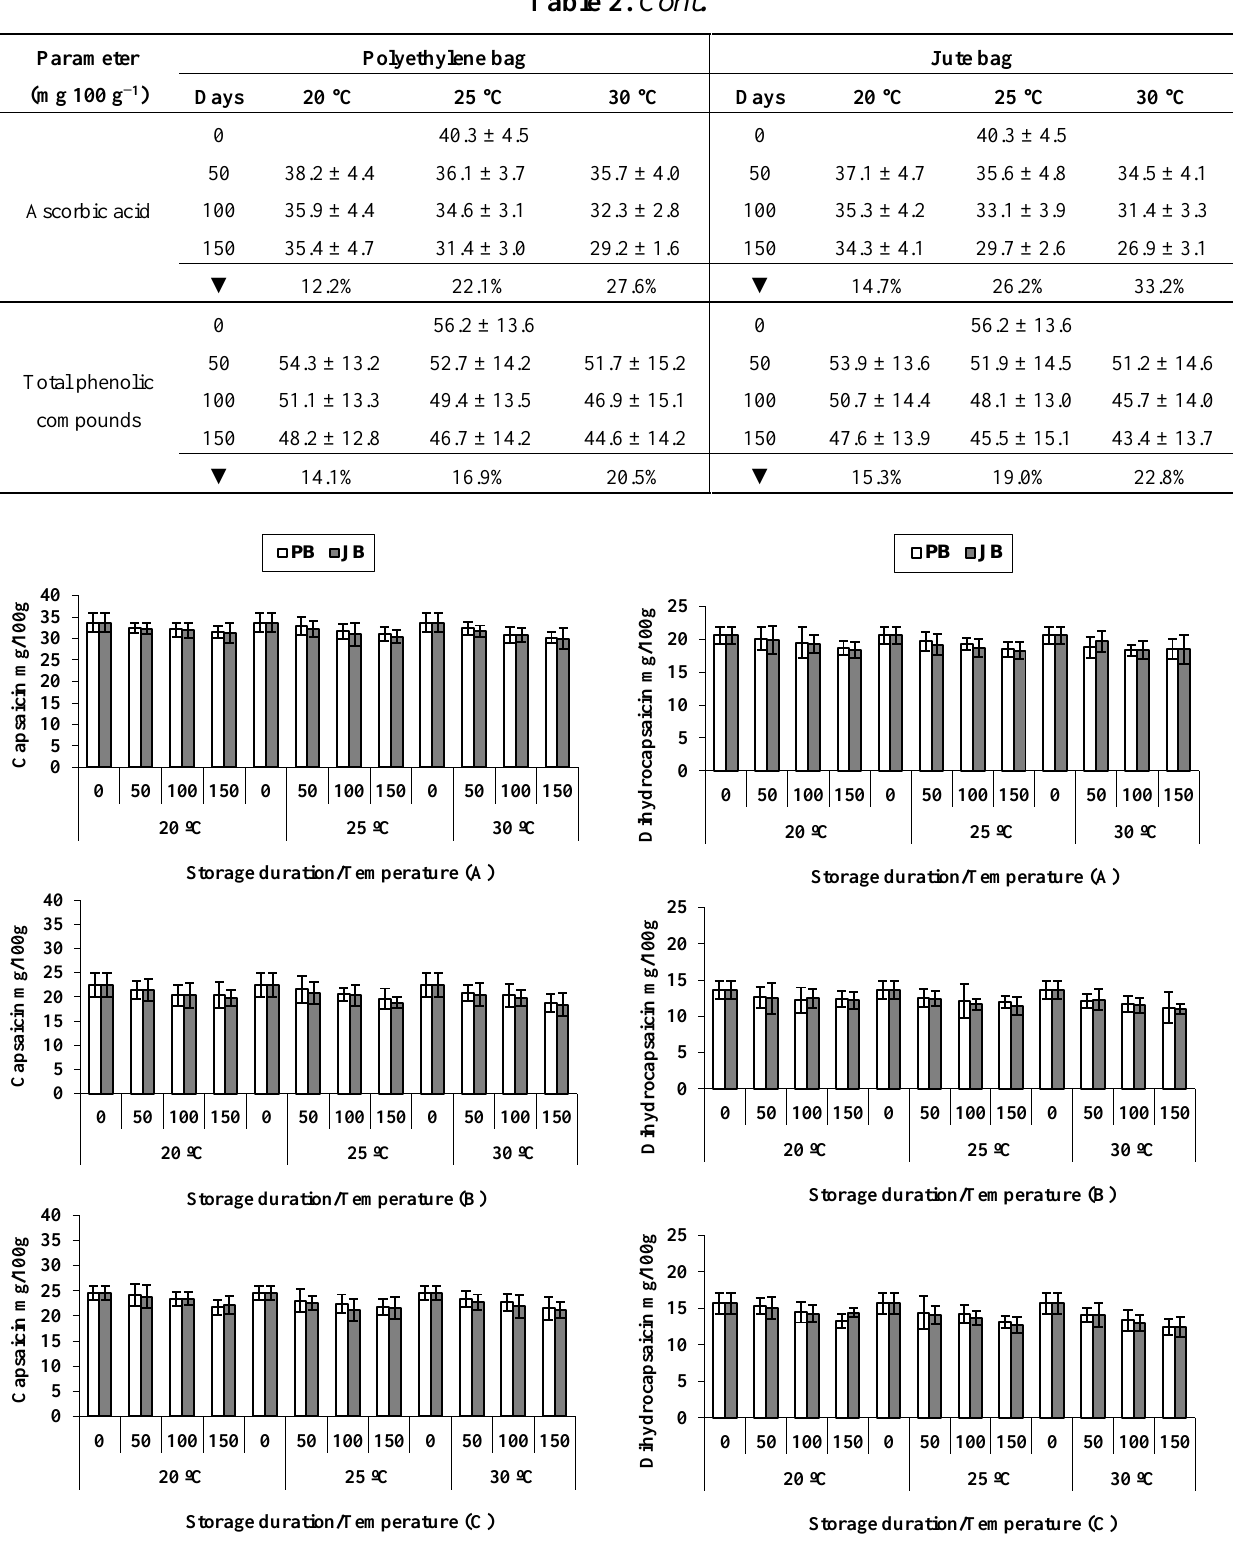
Figure 1. Capsaicin and dihydrocapsaicin concentrations in hot peppers viz . Sky Red ( A ), Maha ( B ) and Wonder King ( C ) at different temperatures and packaging materials (PB, polyethylene bag; JB, jute bag) during five months’ storage. Vertical bars show ± SD of n = 3